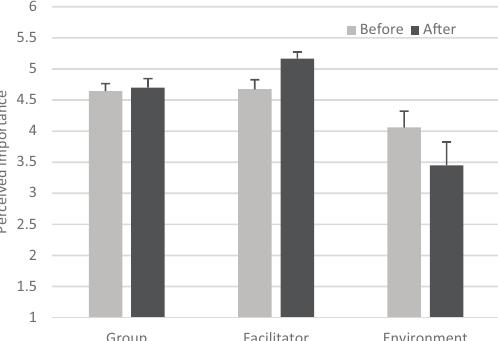
Figure 3. Importance of the group, the facilitator and the environment as rated by experts before and after the test (source: created by